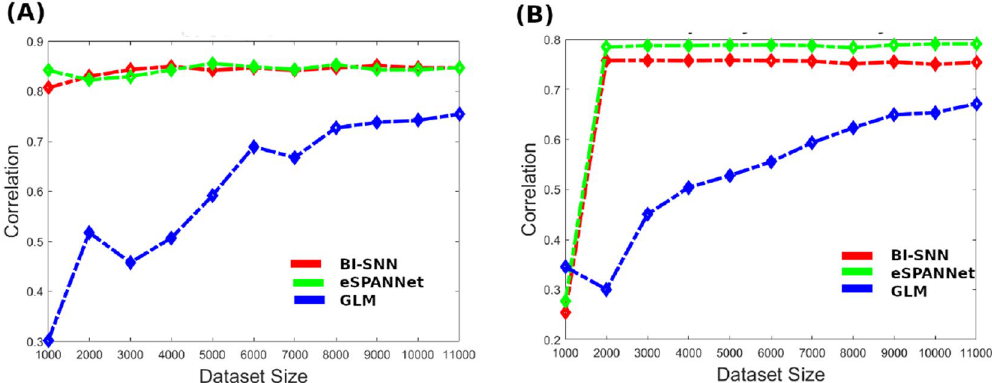
Figure 5. The feasibility of BI-SNN to learn from a smaller amount of training dataset. ( A ) Cross-correlation between the actual and predicted muscle activity of the flexor digitorum muscle activity with respect to the training dataset size. ( B ) Cross-correlation between the actual and predicted orientation of the index finger with respect to the training dataset size.